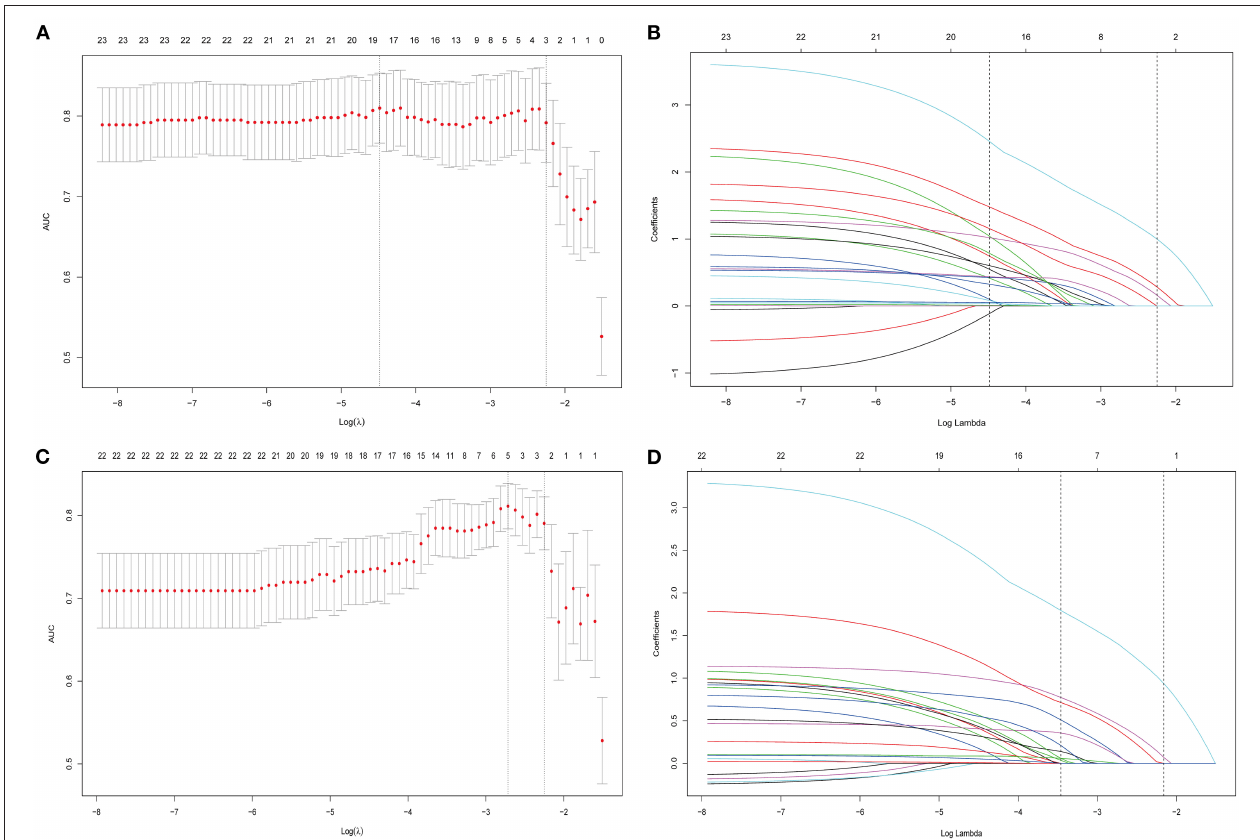
FIGURE 3 | All imaging features were selected by regularized multivariate logistic regression with the least absolute shrinkage and selection operator (LASSO) method in the training cohort. (A) Twenty-three features (with AA) were reduced to three potential predictors to build the first model in the training cohort; the area under the receiver operating characteristic curve (AUC) was plotted vs. log ( λ ). Dotted vertical lines were drawn at the optimal values using the minimum criteria and the 1 standard error of the minimum criteria (the 1-SE criteria). (B) A coefficient profile plot was produced against the log ( λ ) sequence. A vertical line was drawn at the value selected by 10-fold cross-validation, where optimal λ (0.1052) resulted in 3 non-zero coefficients. (C) Twenty-two features (without AA) were reduced to two potential predictors to build the second model in the training cohort; the area under the receiver operating characteristic (AUC) curve was plotted vs. log ( λ ). Dotted vertical lines were drawn at the optimal values using the minimum criteria and the 1 standard error of the minimum criteria (the 1-SE criteria). (D) A coefficient profile plot was produced against the log ( λ ) sequence. A vertical line was drawn at the value selected by 10-fold cross-validation, where optimal λ (0.1155) resulted in 2 non-zero coefficients.